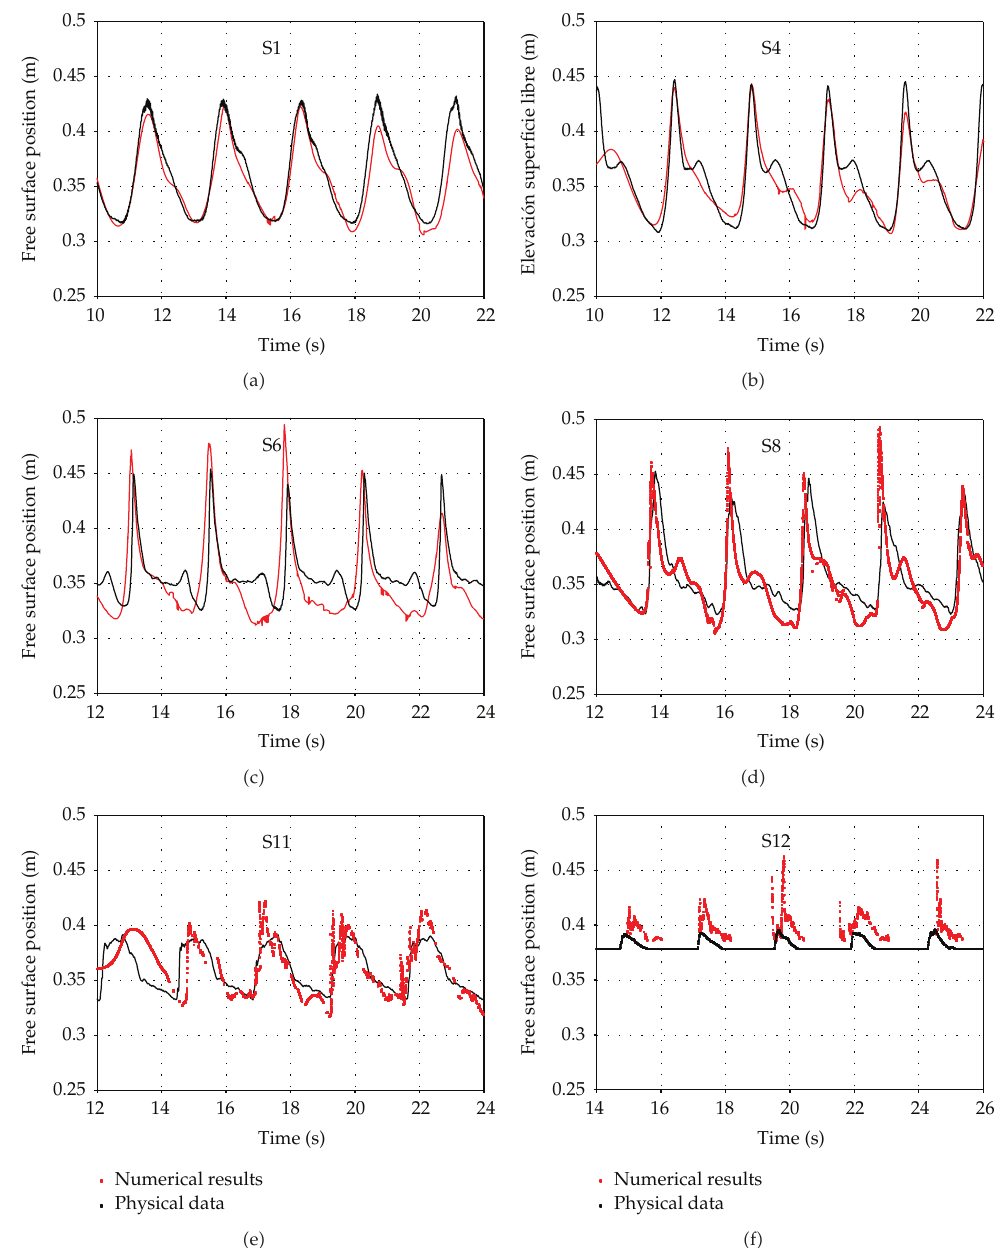
Figure 10: Numerical and physical free surface comparison at six di ff erent locations, corresponding to the case with a still water level of